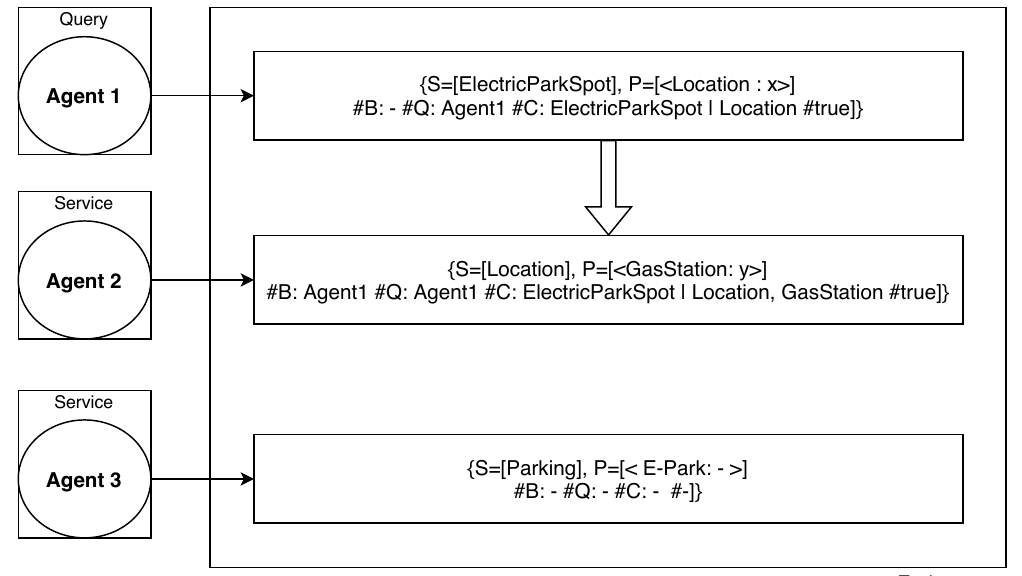
Figure 4. Syntactic composition diagram of the electric car parking